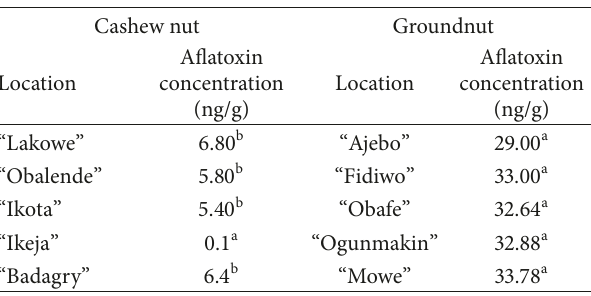
Table 5: Aflatoxin concentration of nuts. Cashew nut Groundnut